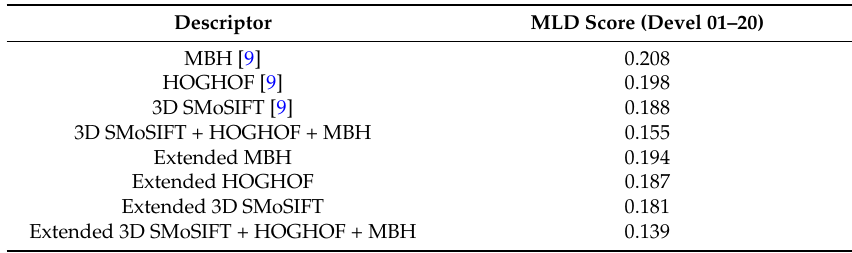
Table 3. The performance validation of the extended 3D SMoSIFT, HOGHOF and MBH feature descriptors (devel 01–devel